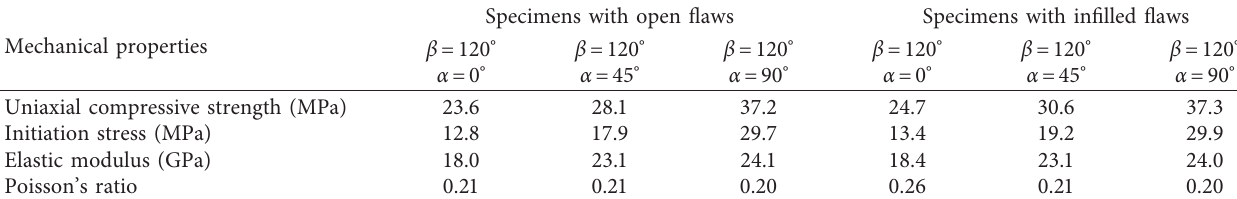
Table 5: Mechanical properties of specimens with two parallel open flaws or infilled flaws. Specimens with open flaws Specimens with infilled Mechanical properties